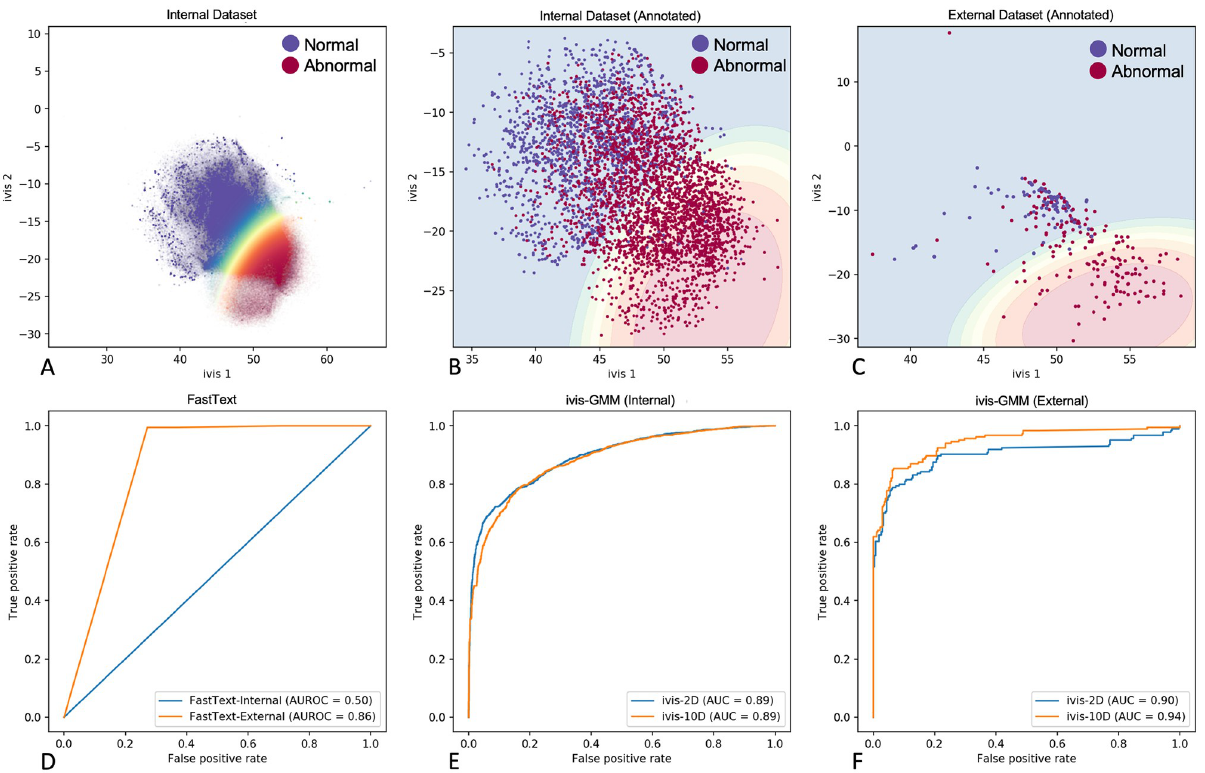
Fig 6. Unsupervised report classification using fastText, ivis, and Gaussian Mixture Model clustering. A. Two-dimensional ivis representation of 50-dimensional fastText embeddings of n = 495,179 unlabelled radiological reports from NHS GGC. Colour gradient reflects posterior probability of Normal and Abnormal report cluster. B. Scatterplot of predicted ivis embeddings for n = 3,715 expert-labelled reports in the internal testing set. Blue and red points represent manually-labelled Normal and Abnormal reports respectively. Colour gradient reflects contours of posterior probability distributions obtained from GMM model trained on two-dimensional ivis representations of n = 495,179 unlabelled radiological reports. C. Scatterplot of predicted ivis embeddings for n = 456 expert-labelled reports in the MIMIC-CXR testing set. Blue and red points represent manually-labelled Normal and Abnormal reports respectively. Colour gradient reflects contours of posterior probability distributions obtained from GMM model trained on two-dimensional ivis representations of n = 495,179 unlabelled radiological reports. D . ROC curves of unsupervised GMM classifier applied to 50-dimensional fastText embeddings of internal (n = 3,715) and external (n = 456) manually-labelled reports. E-F . ROC curves of unsupervised GMM classifier applied to two- and ten-dimensional ivis embeddings of manually labelled internal (n = 3,715) and external (n = 456) reports.